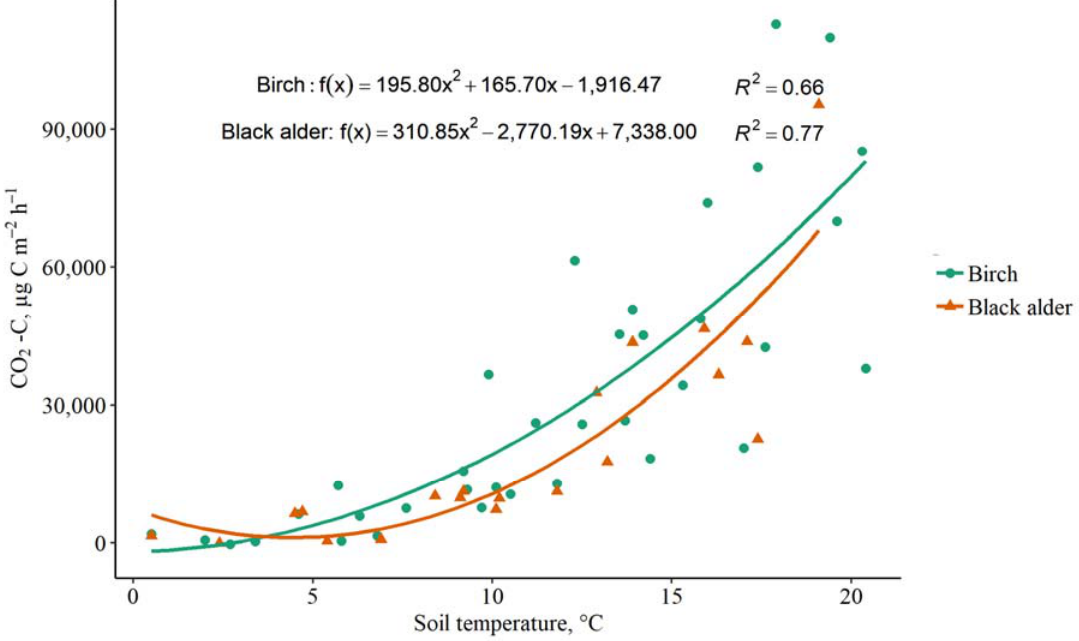
Figure 7. Relationship between CO 2 fluxes from birch and black alder stems and soil temperature.